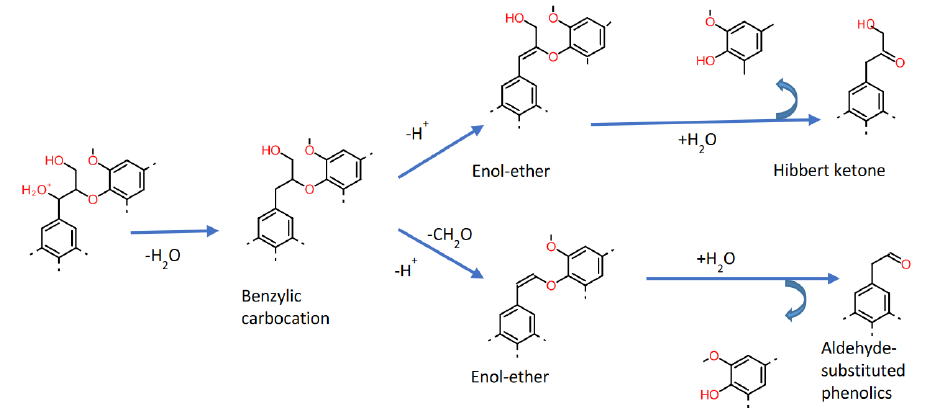
Figure 10. Acidic hydrolysis of lignocellulosic biomass [134].